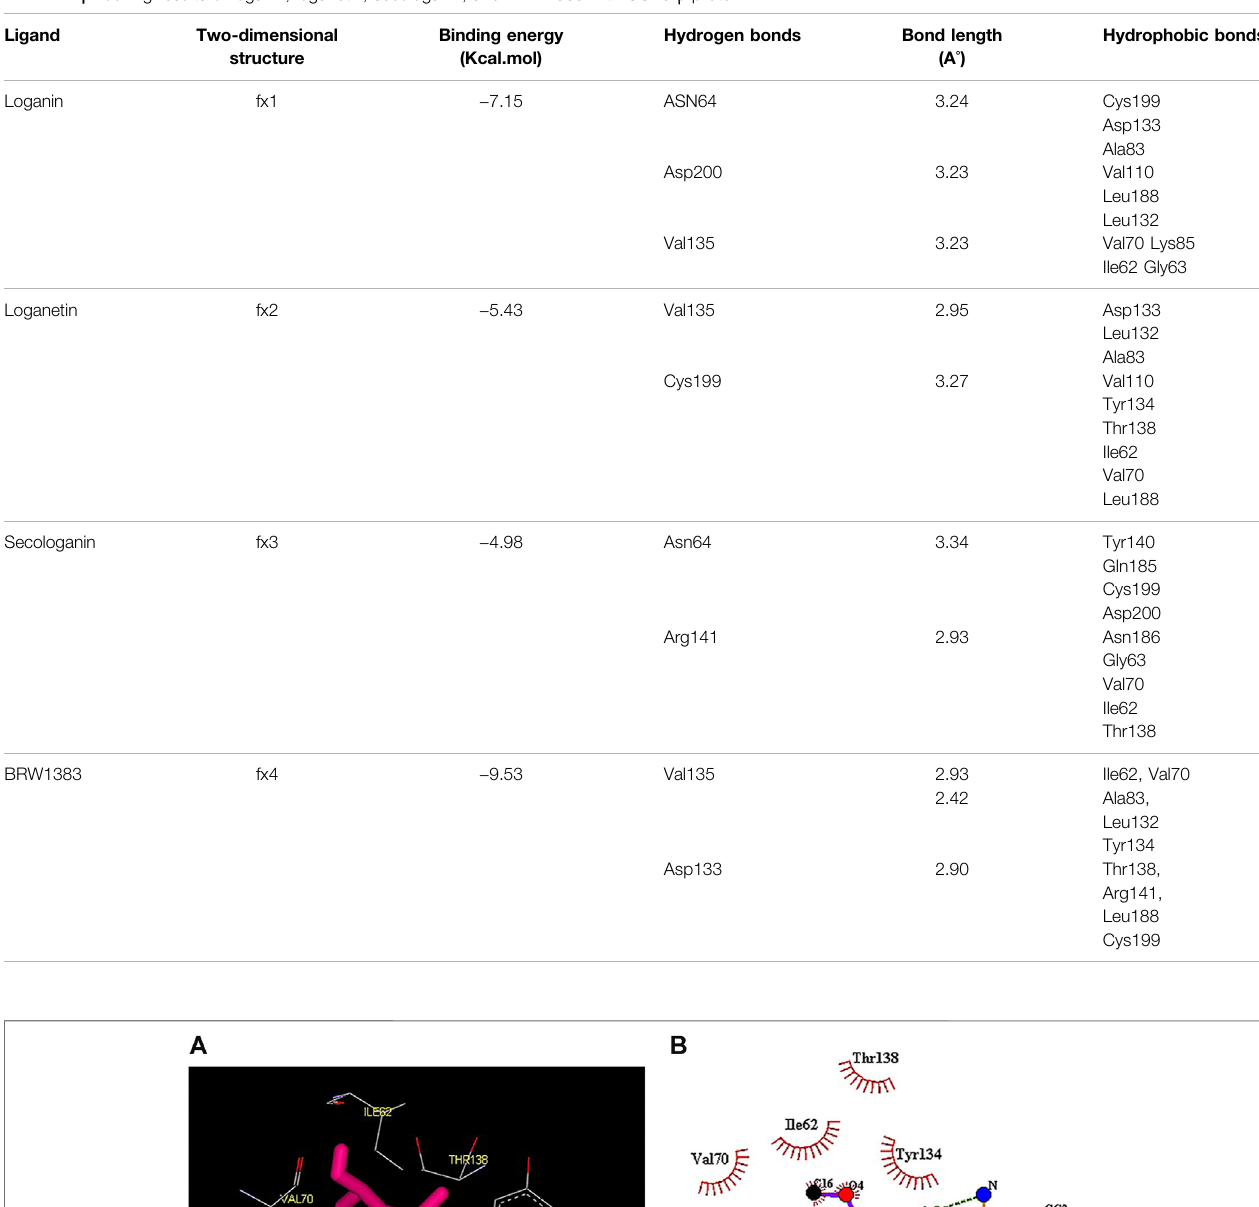
TABLE 2 | Docking results of loganin, loganetin, secologanin, and BRW1383 with GSK3- β protein.